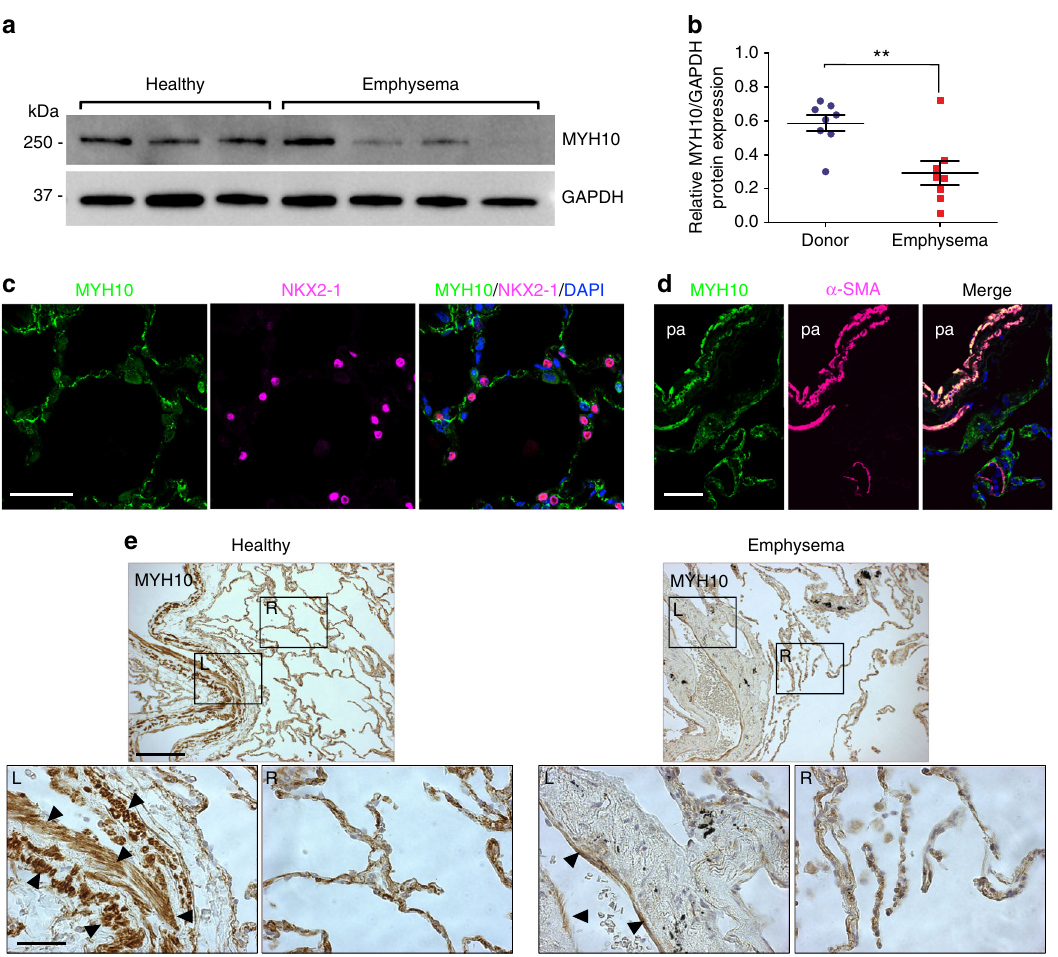
Fig. 7 MYH10 is upregulated in emphysematous human lungs. a Representative western blot for human MYH10 of lung tissues from healthy donors (three individuals) and emphysema patients (four individuals). b Quanti fi cation of MYH10 expression of lung tissues from healthy donors (three individuals) and emphysema patients (four individuals). c Immunostaining for MYH10 and NKX2-1 in adult human lungs. d Immunostaining for MYH10 and α -SMA in adult human lungs. pa, pulmonary artery. e Immunostaining for MYH10 in healthy control and emphysema patient lungs. Arrowheads point to smooth muscle cells. L left, R right. Error bars are means ± s.e.m. ** P < 0.01, two-tailed Student ’ s t -test. Scale bars: 100 μ m ( e (top)), 50 μ m ( c , d ), 30 μ m ( e